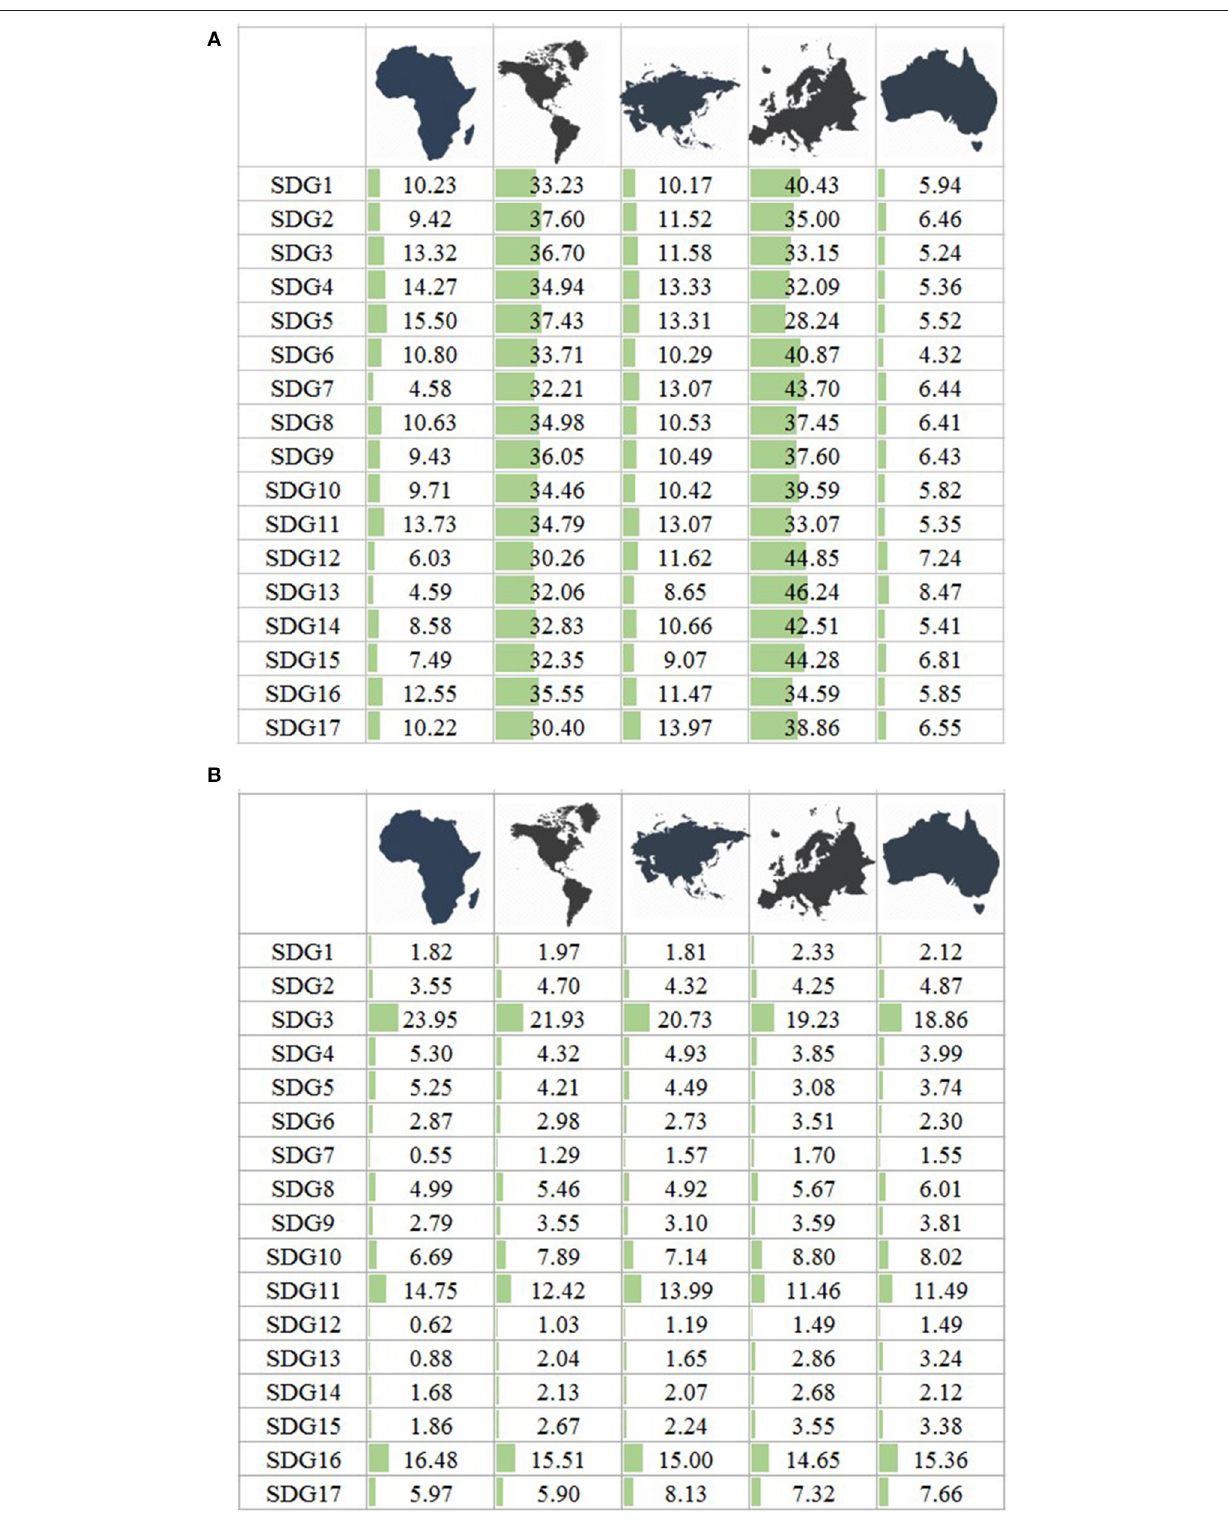
Frontiers in Sustainability |